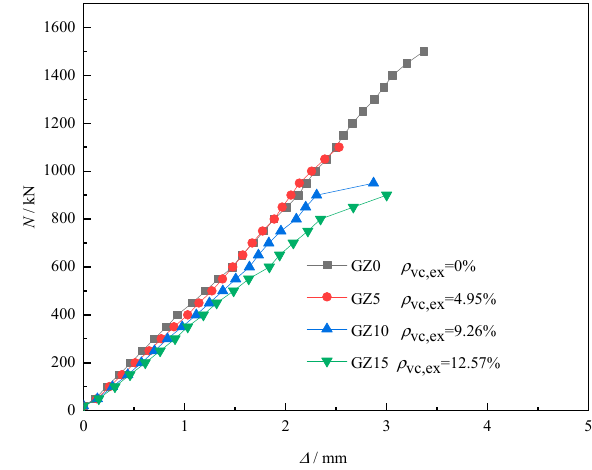
Figure 10. The curves of N - Δ .